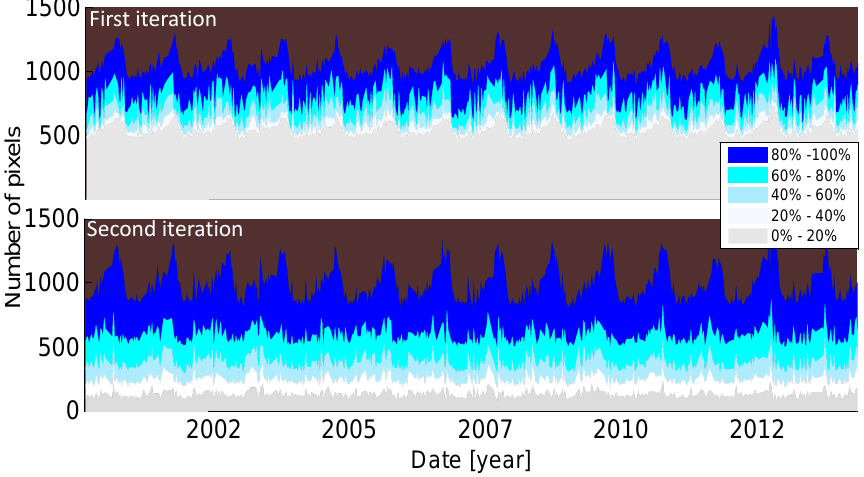
Figure 16. Time series of water masks’ marginal probabilities for the first and second iterations. Monitoring period: February 2000–September